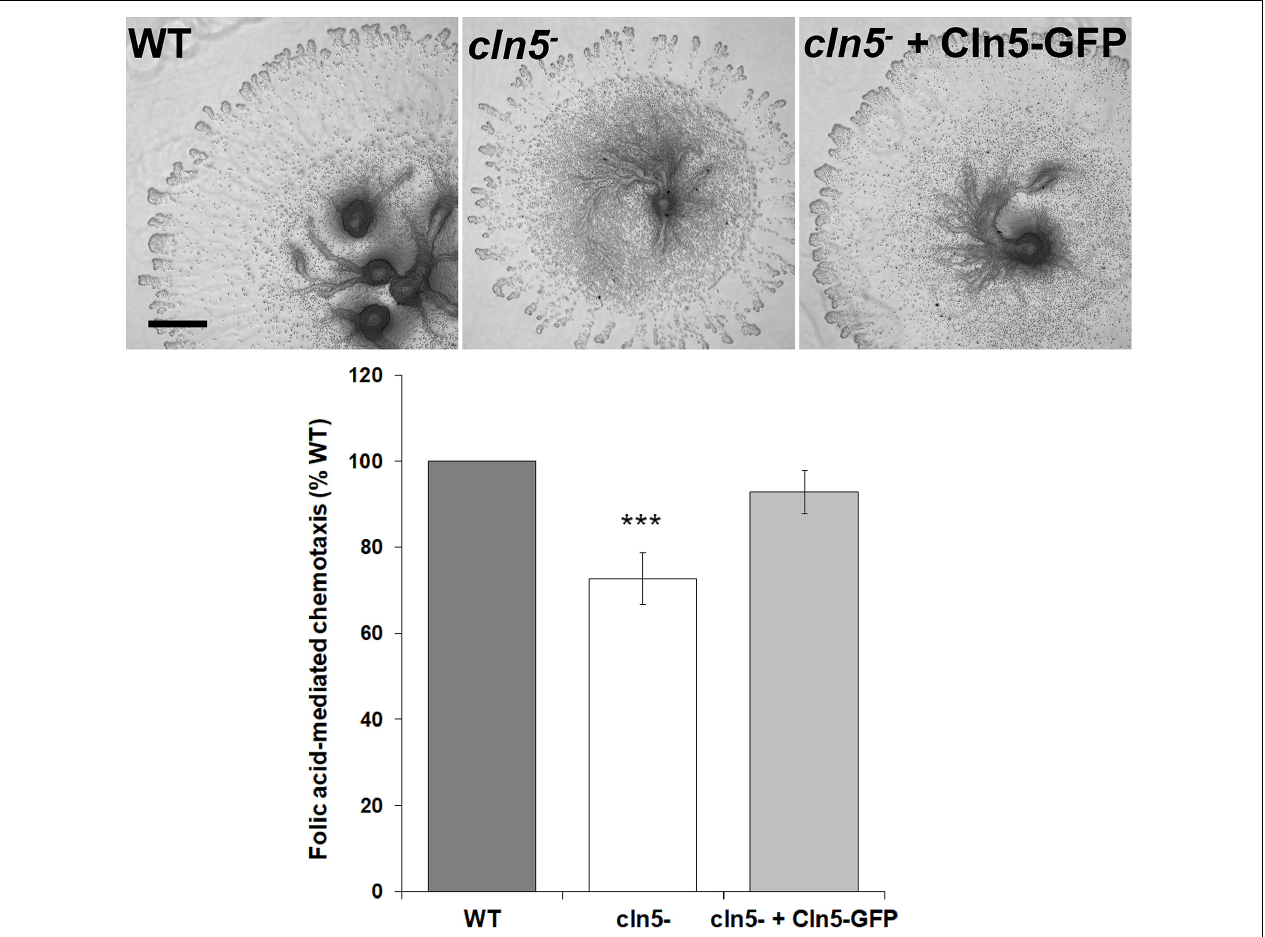
FIGURE 3 | Effect of cln5 -deficiency on folic acid-mediated chemotaxis. WT, cln5 − , and cln5 − + Cln5-GFP cells were deposited onto 0.5% agar/KK2 buffer + folic acid (50 µ M). Images were taken once cells were deposited and after 5 h. Scale bar = 500 µ m. The amount of migration of each cell line was quantified and the raw values were then expressed as a percentage of the migration of WT cells. Data presented as mean folic acid-mediated chemotaxis (% WT) ± SEM ( n ≥ 5). Statistical significance was assessed using the one sample t -test. *** p < 0.001 vs. WT.